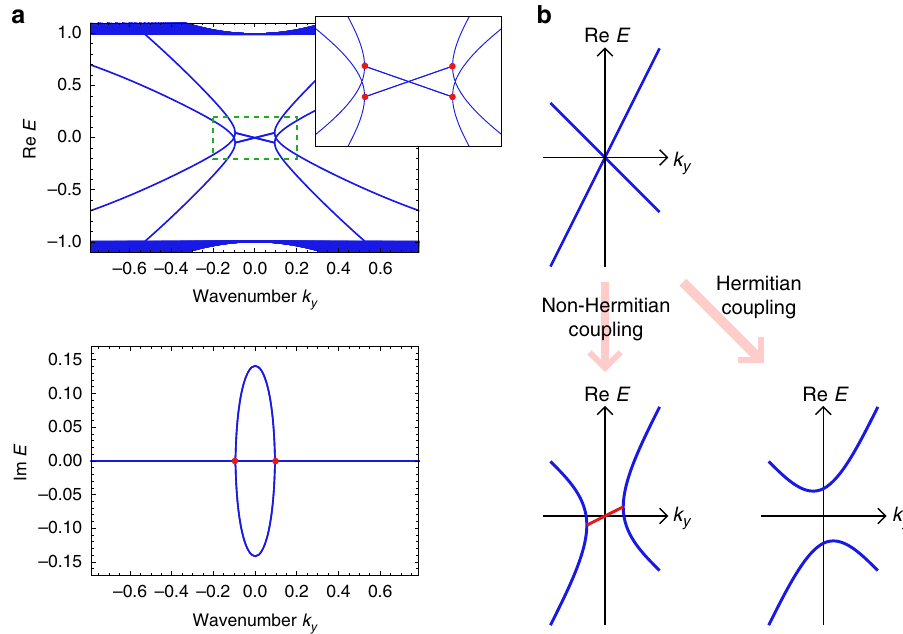
Fig. 4 Band structure for realizing lasing edge modes with nonzero group velocities. a Combining the Qi-Wu-Zhang (QWZ) model with large hoppings and the time-reversal QWZ model by a non-Hermitian coupling, we obtain the model with the edge band structure shown in the main panels. The edge dispersions between the pairs of EPs (red points) exhibit the nonzero imaginary part of the energy and the nonzero slope of the real part of the energy. Since the slope of the real part of the energy corresponds to the group velocity of the edge mode, these lasing edge modes have nonzero group velocity and propagate along the edge of the sample. The inset presents the enlarged view of the low momentum region indicated by the green dashed box and the red points represent the EPs in the edge dispersions. The parameters used are u = − 1, β = 0.2, and β 0 ¼ 0 : 1. b To obtain the lasing edge modes with nonzero group velocity, we utilize two edge modes which have opposite signs and different absolute values of the slope of the dispersion relation. By combining these edge modes by a non-Hermitian coupling term, we obtain exceptional edge modes, which can be applied to construct a topological insulator laser while Hermitian couplings open the gap owing to the avoided